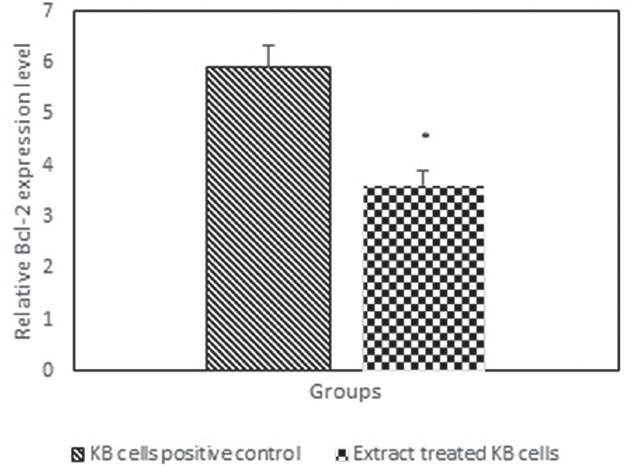
FIGURE 5 - Relative intensity of Bcl-2 protein levels were expressed as means in bar graphs. Significant differences from positive control were noted as * P<0.01.